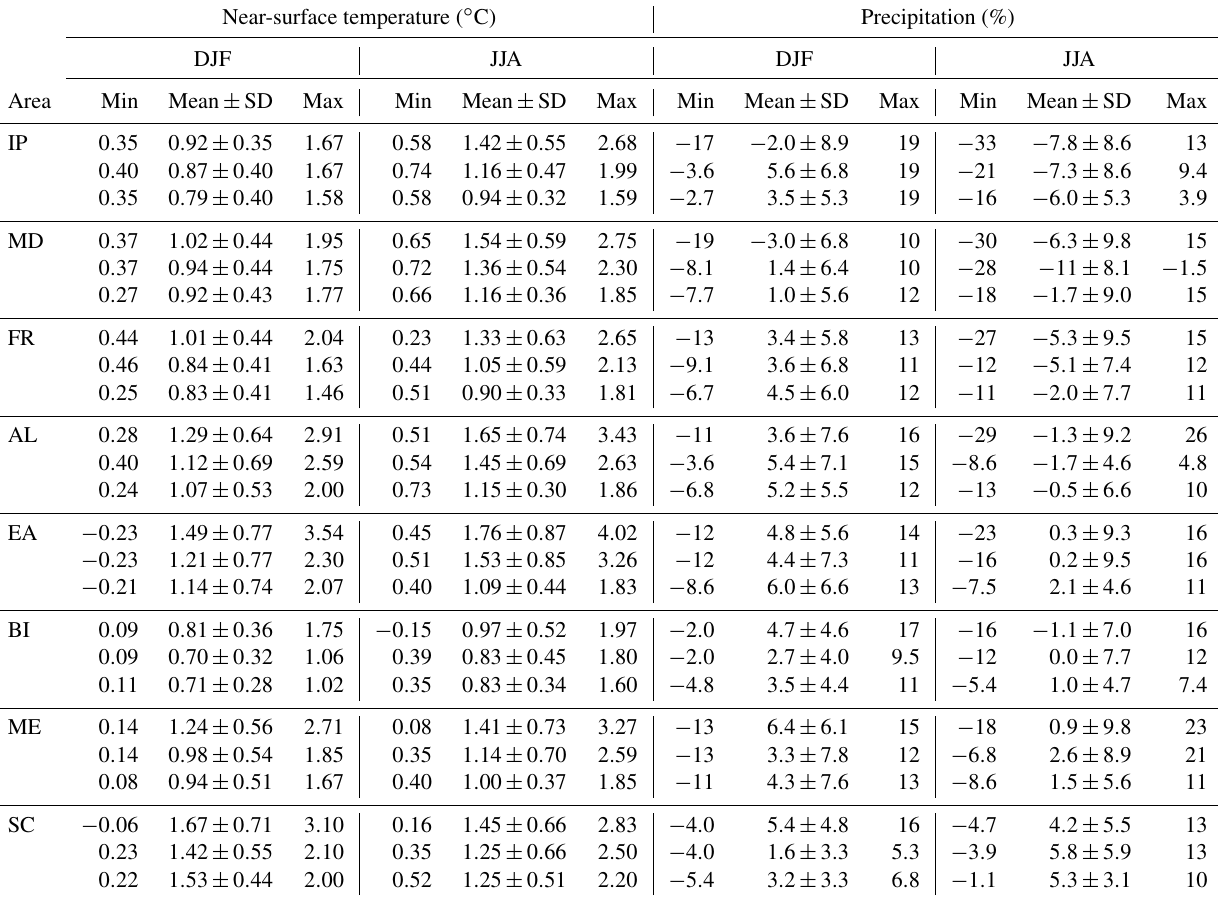
Table 4. Summary statistics showing temperature and precipitation changes at SWL1.5 for the eight regions in Fig. 1. For each region there are three sets of data for each season and variable representing the full CMIP5 ensemble (top), the nine-member GCM ensemble downscaled by the RCMs (middle) and the 18-member RCM ensemble (lower). The numbers represent the minimum (left), maximum (right) and mean plus or minus 1 SD (middle) of the ensemble members’ individual area mean climate